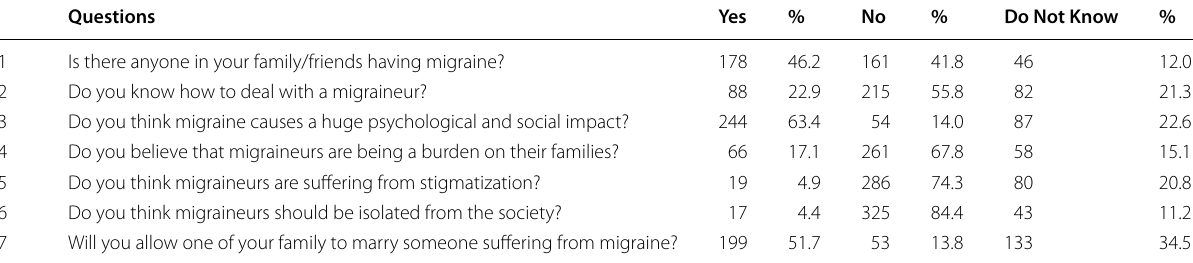
Table 3 Information About Migraine in the General